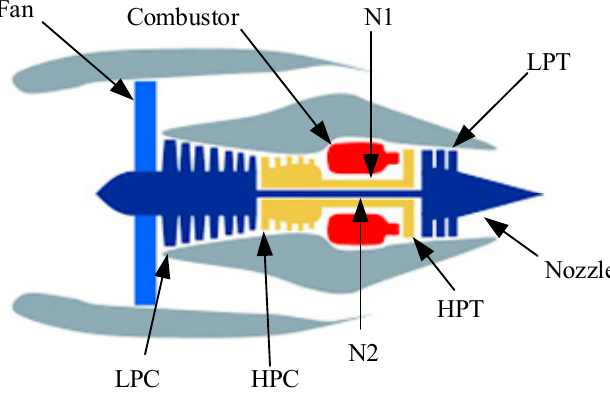
Figure 7. Simplified diagram of engine simulated in the Commercial Modular Aero-Propulsion System Simulation (C-MAPSS) [32].